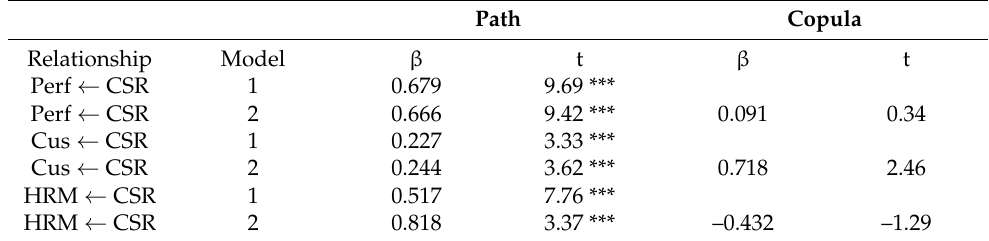
Table 6. Gaussian Copula Approach.